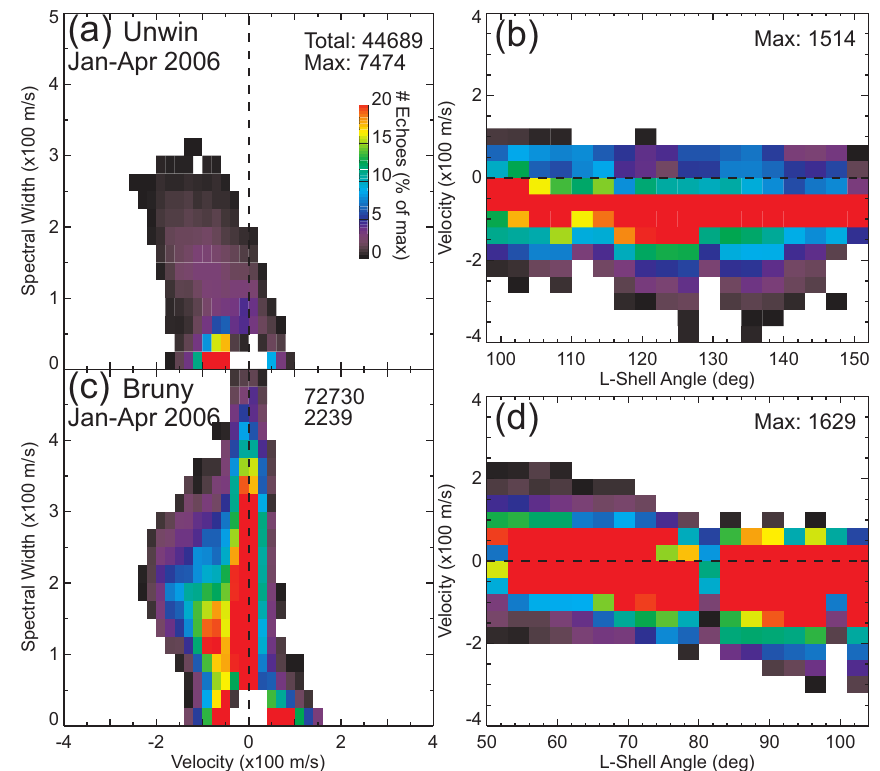
Fig. 6. Panels (a) and (c) show the 2-D occurrence plots of the spectral width versus Doppler velocity for the Unwin and Bruny Island radar, respectively. The data were collected in the evening sector in January–April 2006. The values shown are the numbers of echoes divided by the maximum echo number in all plot cells and expressed as percentage. The colour scale is indicated in panel (a). The total number of echoes and the maximum echo number are indicated in the top-right corner of each panel. Panels (b) and (d) show similar 2-D occurrence plots of the Doppler velocity versus L-shell